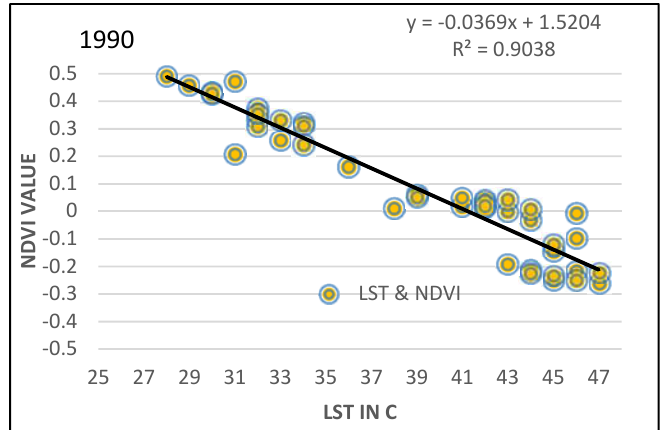
y = -0.0369x + 1.5204 R² = 0.9038